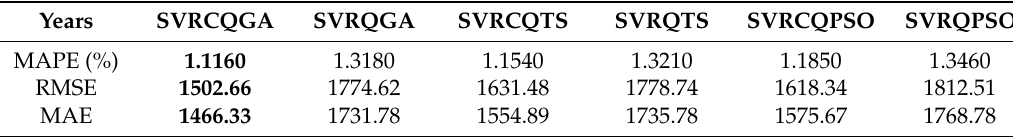
Table 6. Forecasting indexes of SVRCQGA, SVRQGA, and other models (Example 2).